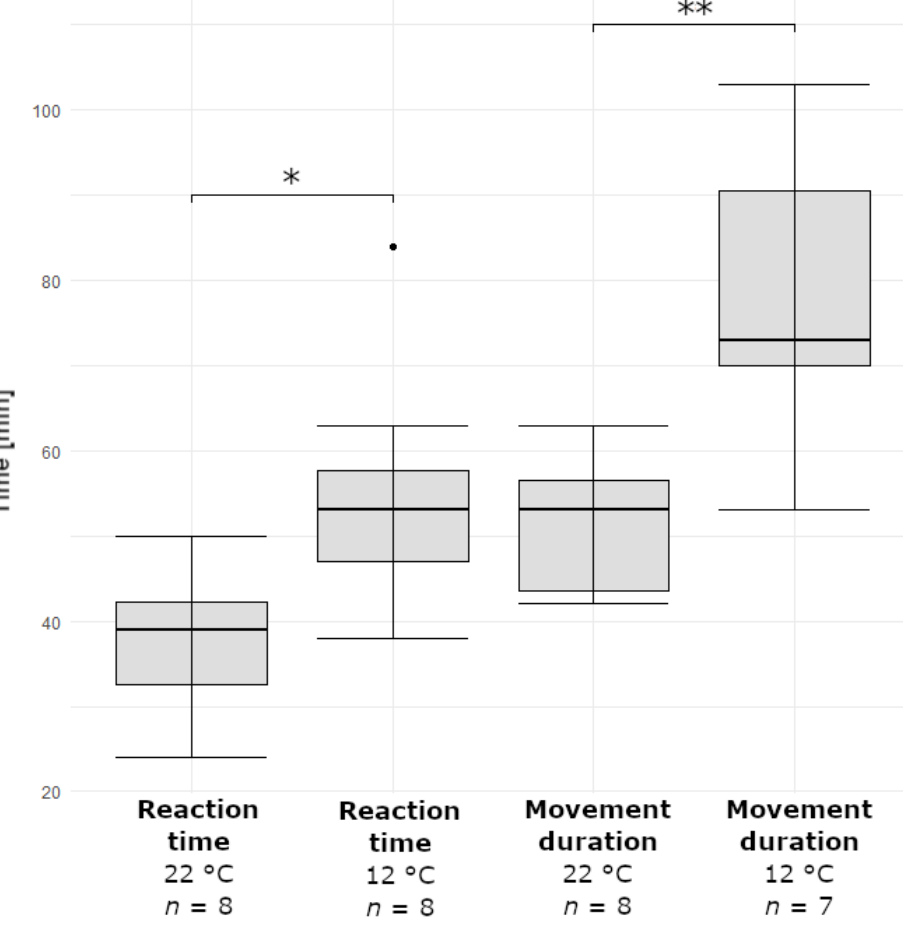
Figure 4. Comparative analyses of reaction time and movement duration of stalked glands triggered in warm (22 °C) and cold (12 °C) temperature regimes. The asterisks indicate the significance levels ( * ≙ 0.01 ≤ p < 0.05; ** ≙ 0.001 ≤ p < 0.01; ns ≙ not significant). The sample sizes ( n ) are indicated.